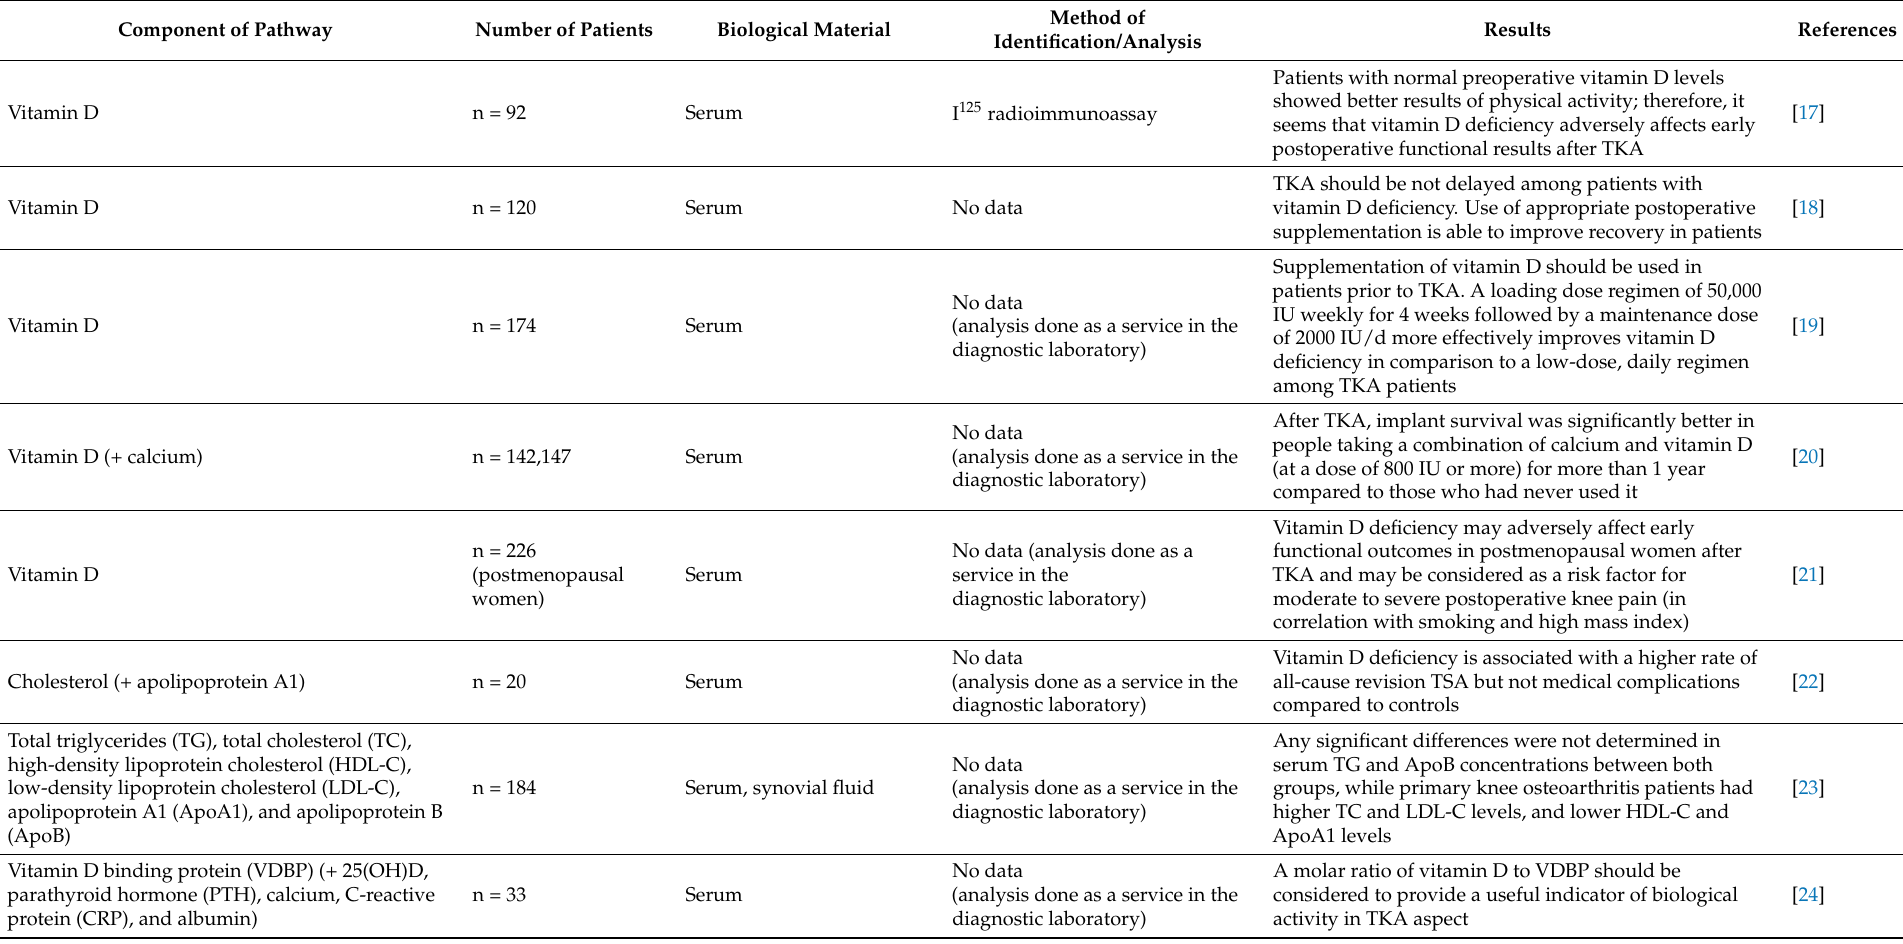
Table 1. Characteristic of vitamin D components in total knee